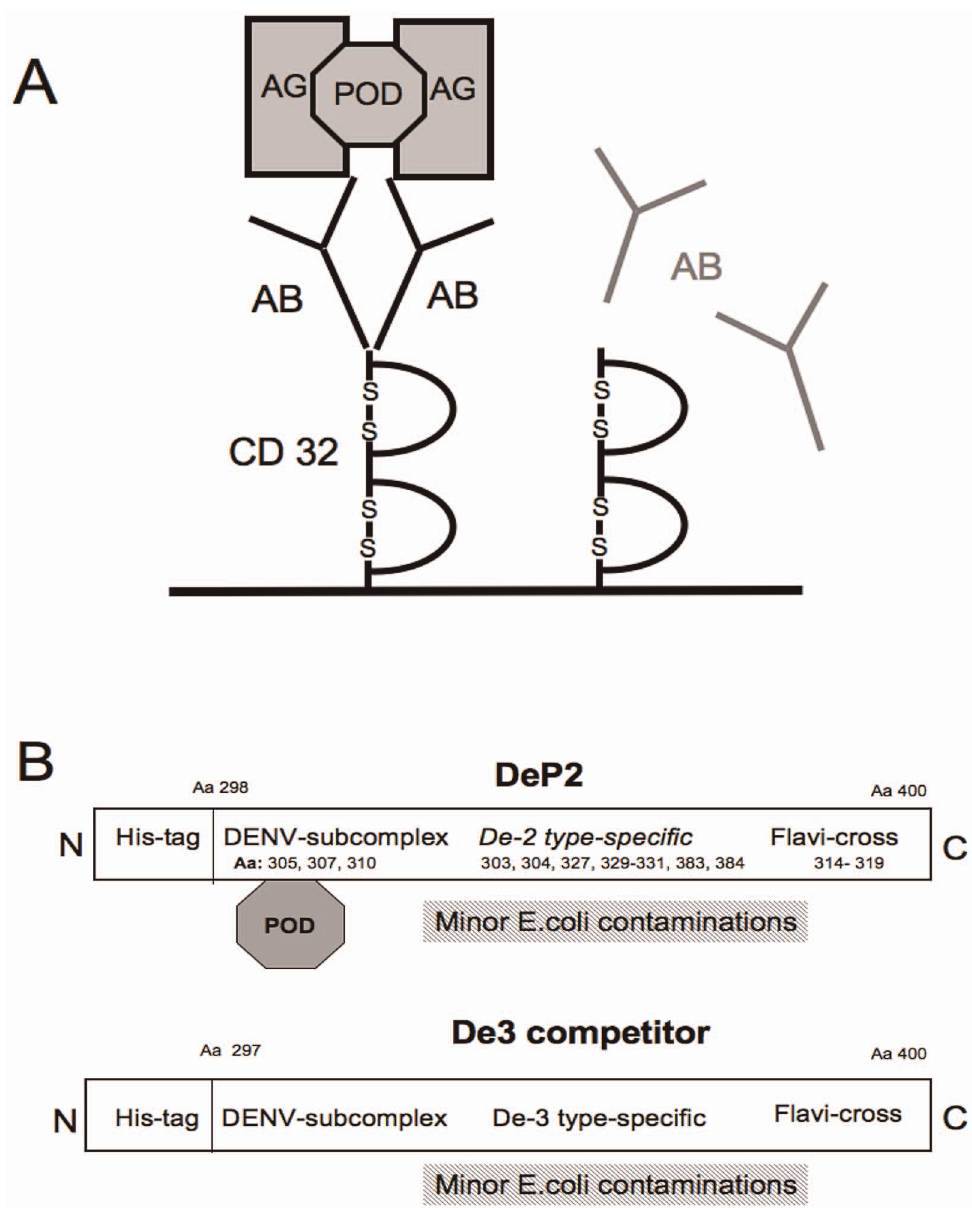
Figure 1. ICB ELISA procedure. A : During incubation of serum samples containing antibody (AB) and POD-labeled recombinant antigen (POD, AG) immune complexes form, which in turn are attached to the solid-phase coated with CD32. Non-specific antibodies (in grey) do neither bind to the antigen nor to CD32. Competition with unlabeled antigen is not shown. B : Schematic drawing of the POD-labeled EDIII domain of DENV-2 (DeP2) and of the unlabeled EDIII domain of DENV-3 (De3) serving as competitor in the ICB-ELISA. While type-specific epitopes on the DeP2 and De3 are different from each other, cross-reacting epitopes are almost identical. In the presence of an excess of De3, cross-reacting antibodies will no longer bind to sub-domain epitopes on the DeP2 antigen. Amino acids (aa) involved in epitope formation [29] are also indicated. Of note, a subcomplex (aa 305,307) and a type-specific (aa 303,304) epitope are in close proximity.